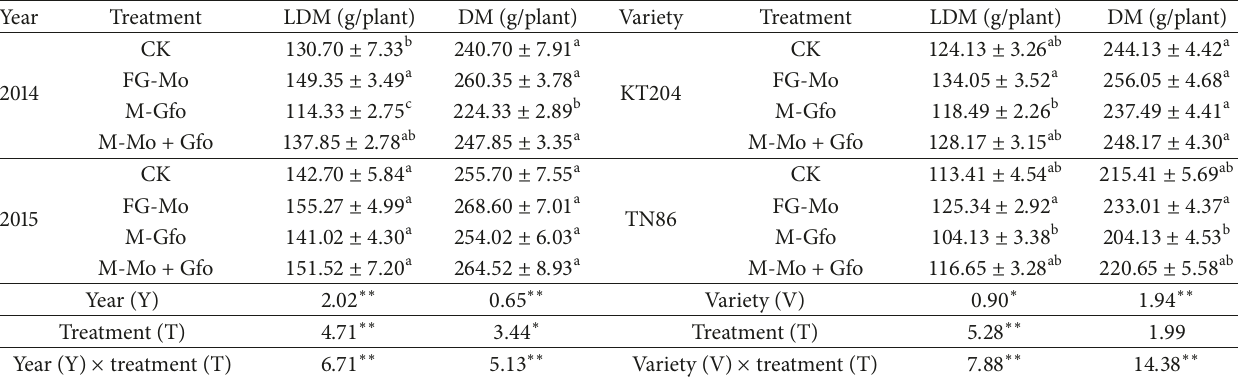
Table 1: ANOVA results of the effects of chemical regulation, year, and tobacco variety and their interactions on LDM and DM before harvest.